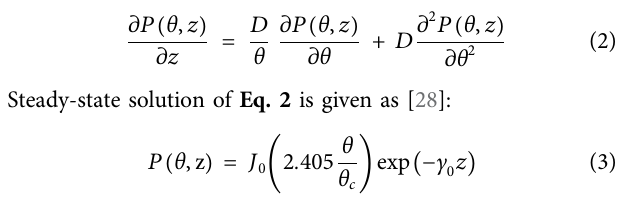
Frontiers in Physics |